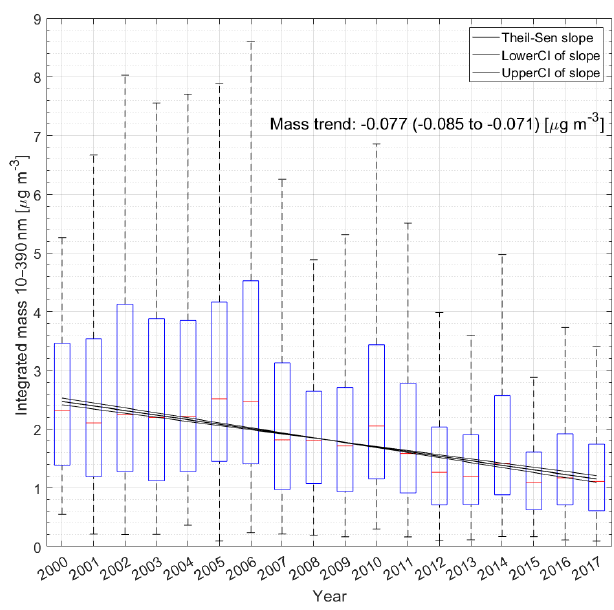
Figure 11. Box–whisker plot of daily mean mass concentration 10– 390nm assuming density of 1gcm − 3 for Aspvreten 2000–2017. Theil–Sen estimator slope and associated 95%CI of slope is indi- cated in the figure by solid black lines. Note that outliers are ex- cluded in the figure for improved clarity. Upper and lower bounds of boxes show the 25th–75th percentile range, and whiskers show the 5th–95th percentile range of data. Red lines show the